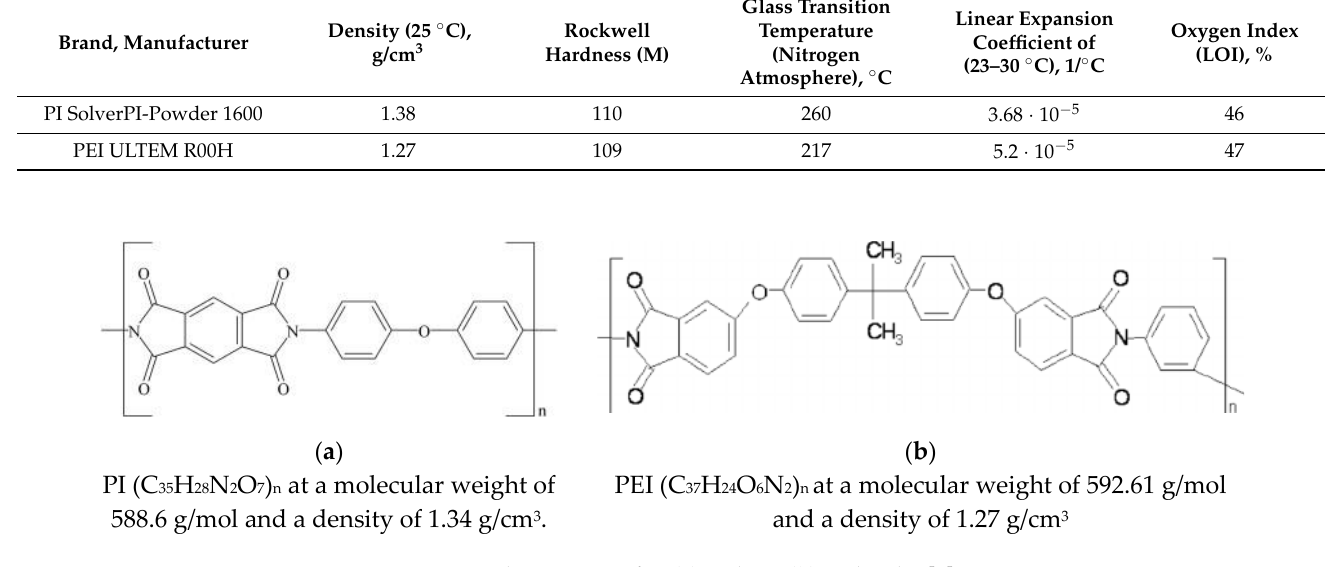
Figure 1. Typical structures of PI ( a ) and PEI ( b ) molecules [4]. Table 2. The fillers for the PI- and PEI-based composites.